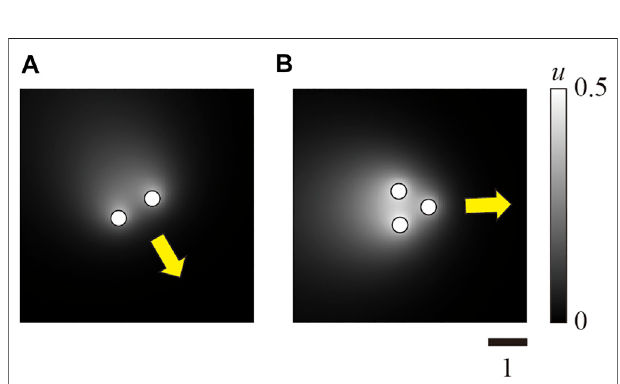
FIGURE 5 | Snapshots of the camphor concentration around the camphor fl oats. (A) Camphor fl oatwith n =2at t =100. (B) Camphor fl oatwith n =3at t =100. κ wassetto0.12,and ℓ wassetto0.5.Correspondingvideos are avialable as Supplementary Video S1, S2 .